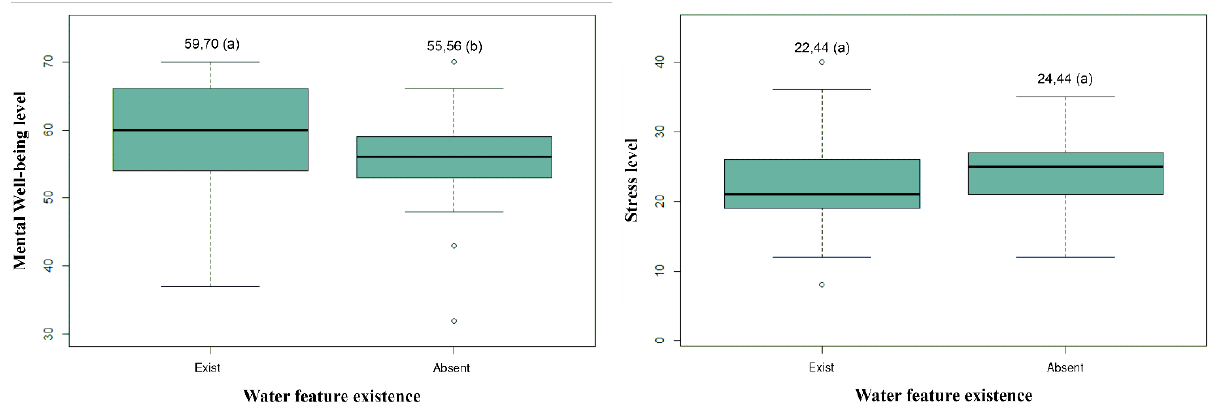
Figure 12 . Box plot with average water feature existence factor related to mental well-being (left) and stress level